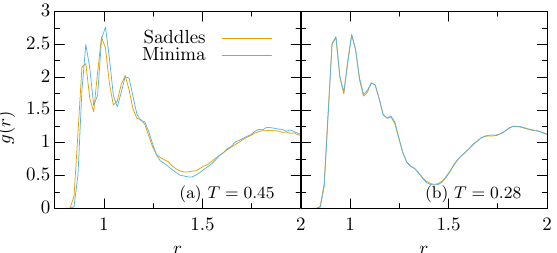
Figure 7: Radial distribution function for saddles and local minima of N = 3000. The temperatures are (a) T = 0.45 and (b) T =